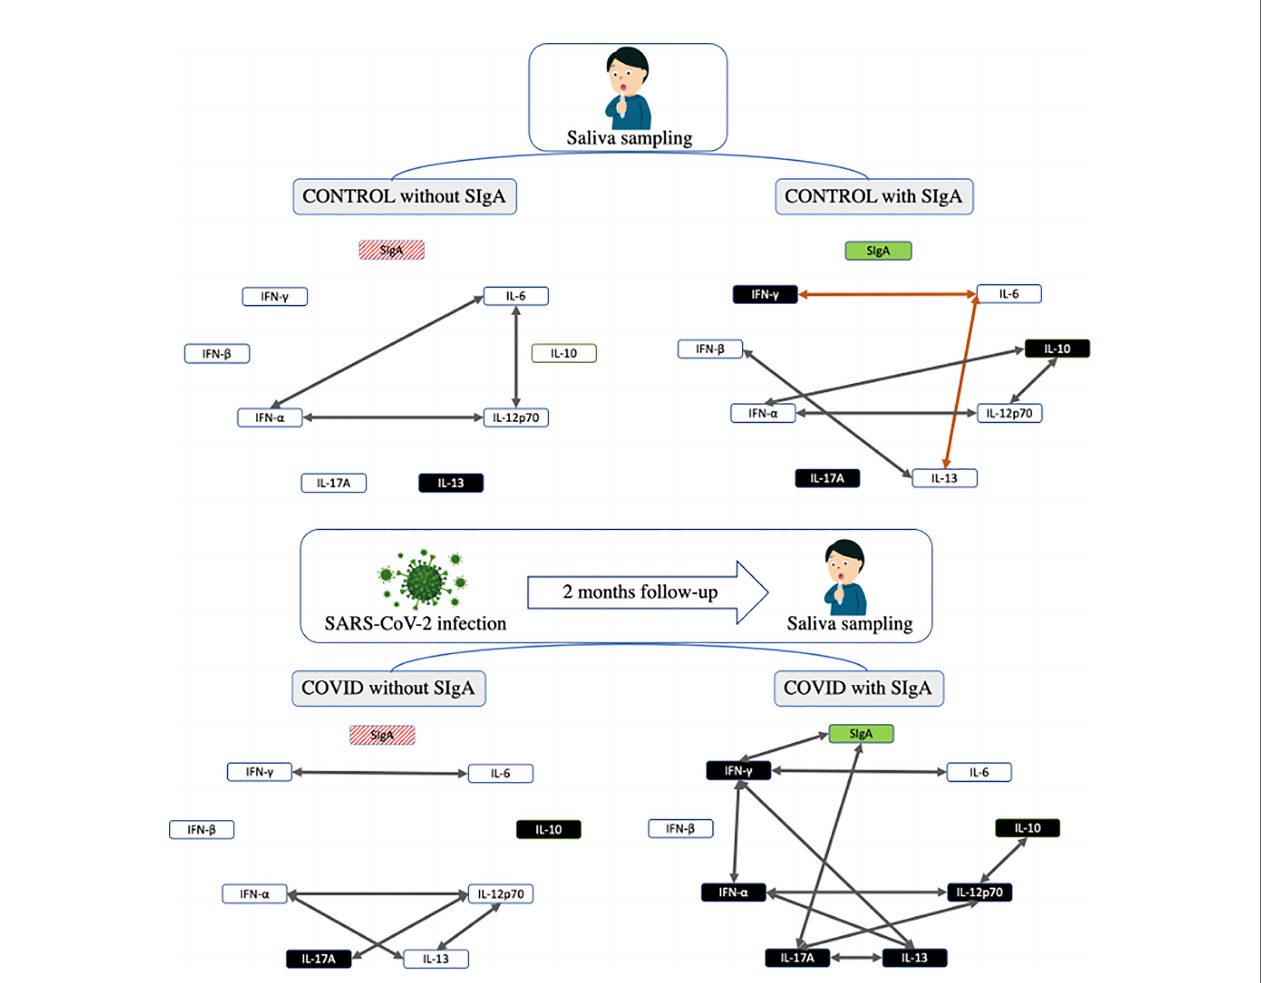
FIGURE 4 | Summarized representation of the main results found in the study. The boxes representing the cytokines are colored in black color indicating an increase in their concentration when compared to the other groups. The arrows represent the correlations found in the study, in which positive correlations appear in gray and negative in